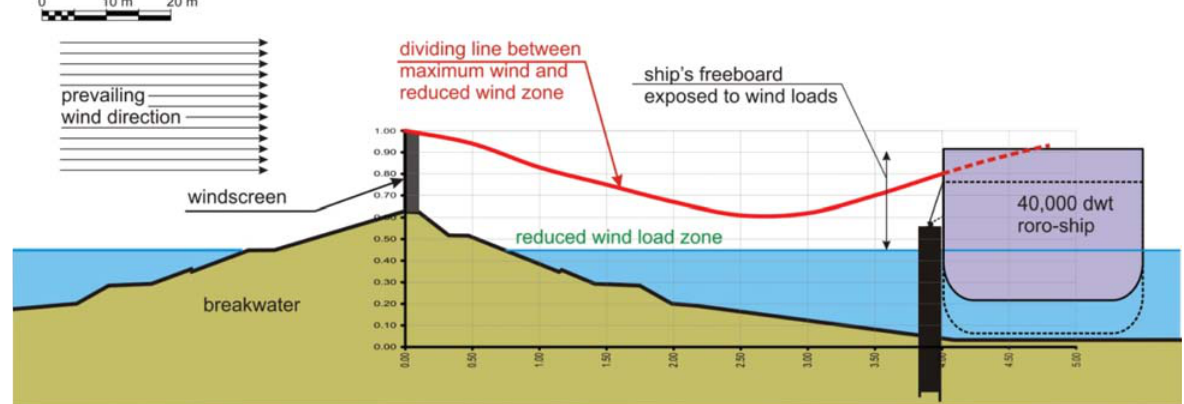
Fig. 15. A typical example: breakwater + windscreen + berth roro-ship